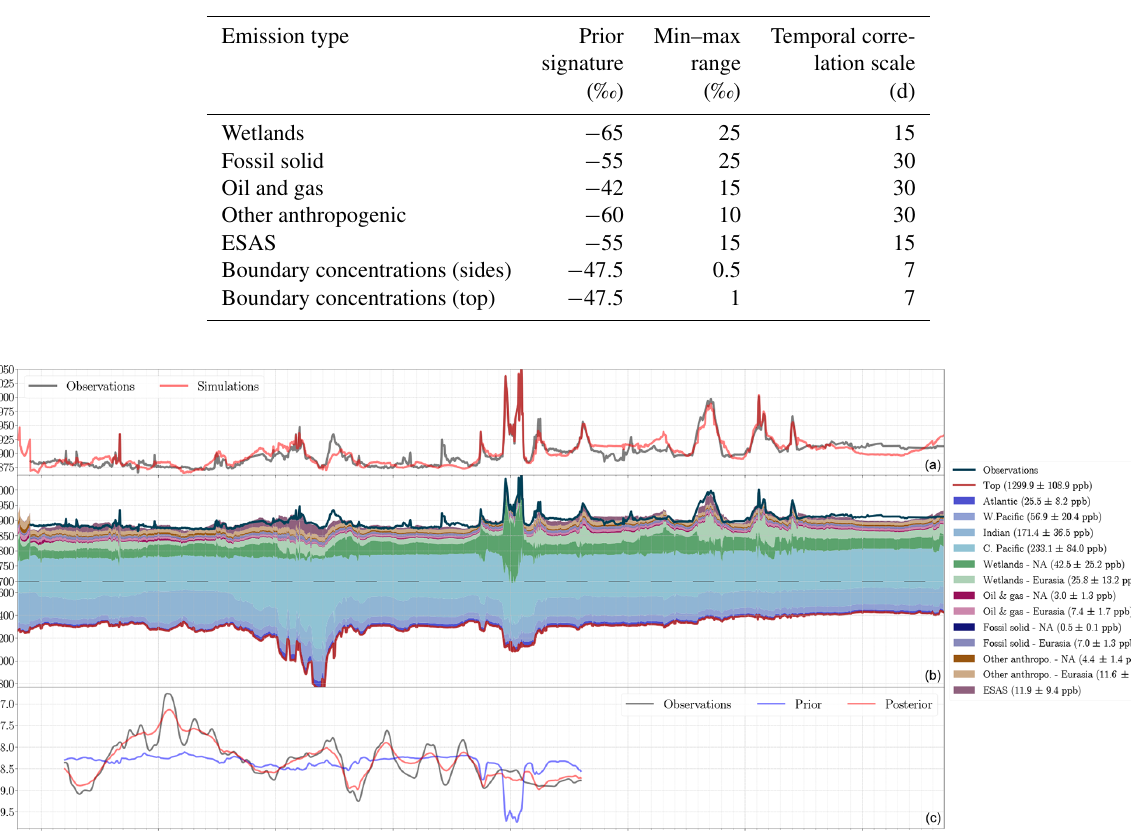
Table 1. Isotopic signatures for the inputs in the CHIMERE model. The min–max range is deduced from existing literature (Sherwood et al., 2017; Sapart et al., 2017). The prior signature is computed as the centre of the min–max range.